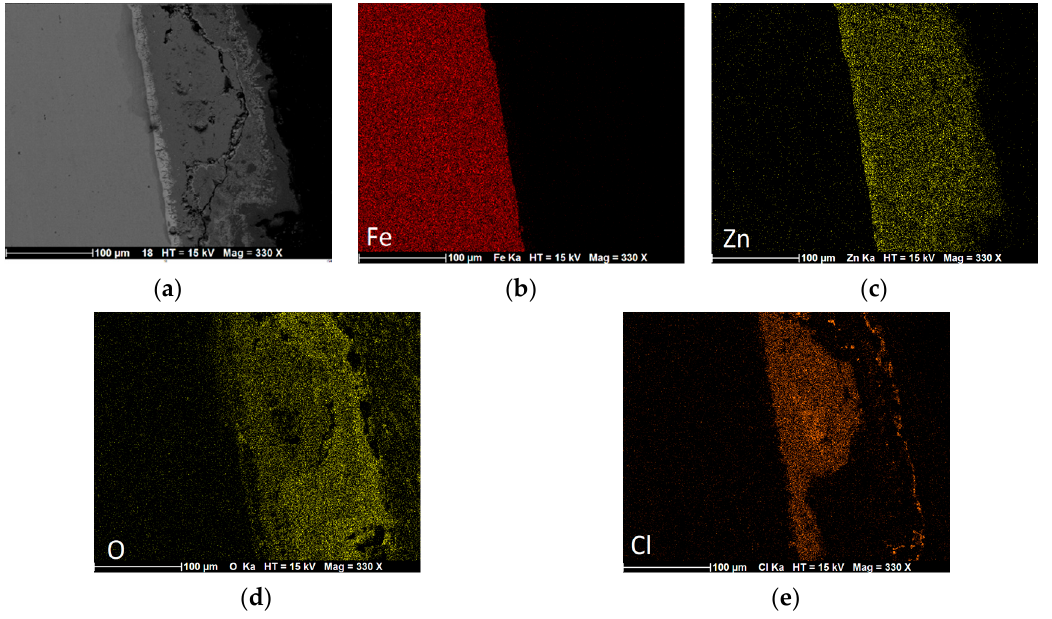
Figure 12. EDS cartography of a 210-day corroded steel wire: ( a ) Microscopic view; ( b ) iron levels; ( c ) zinc levels; ( d ) oxygen levels; and ( e ) chloride